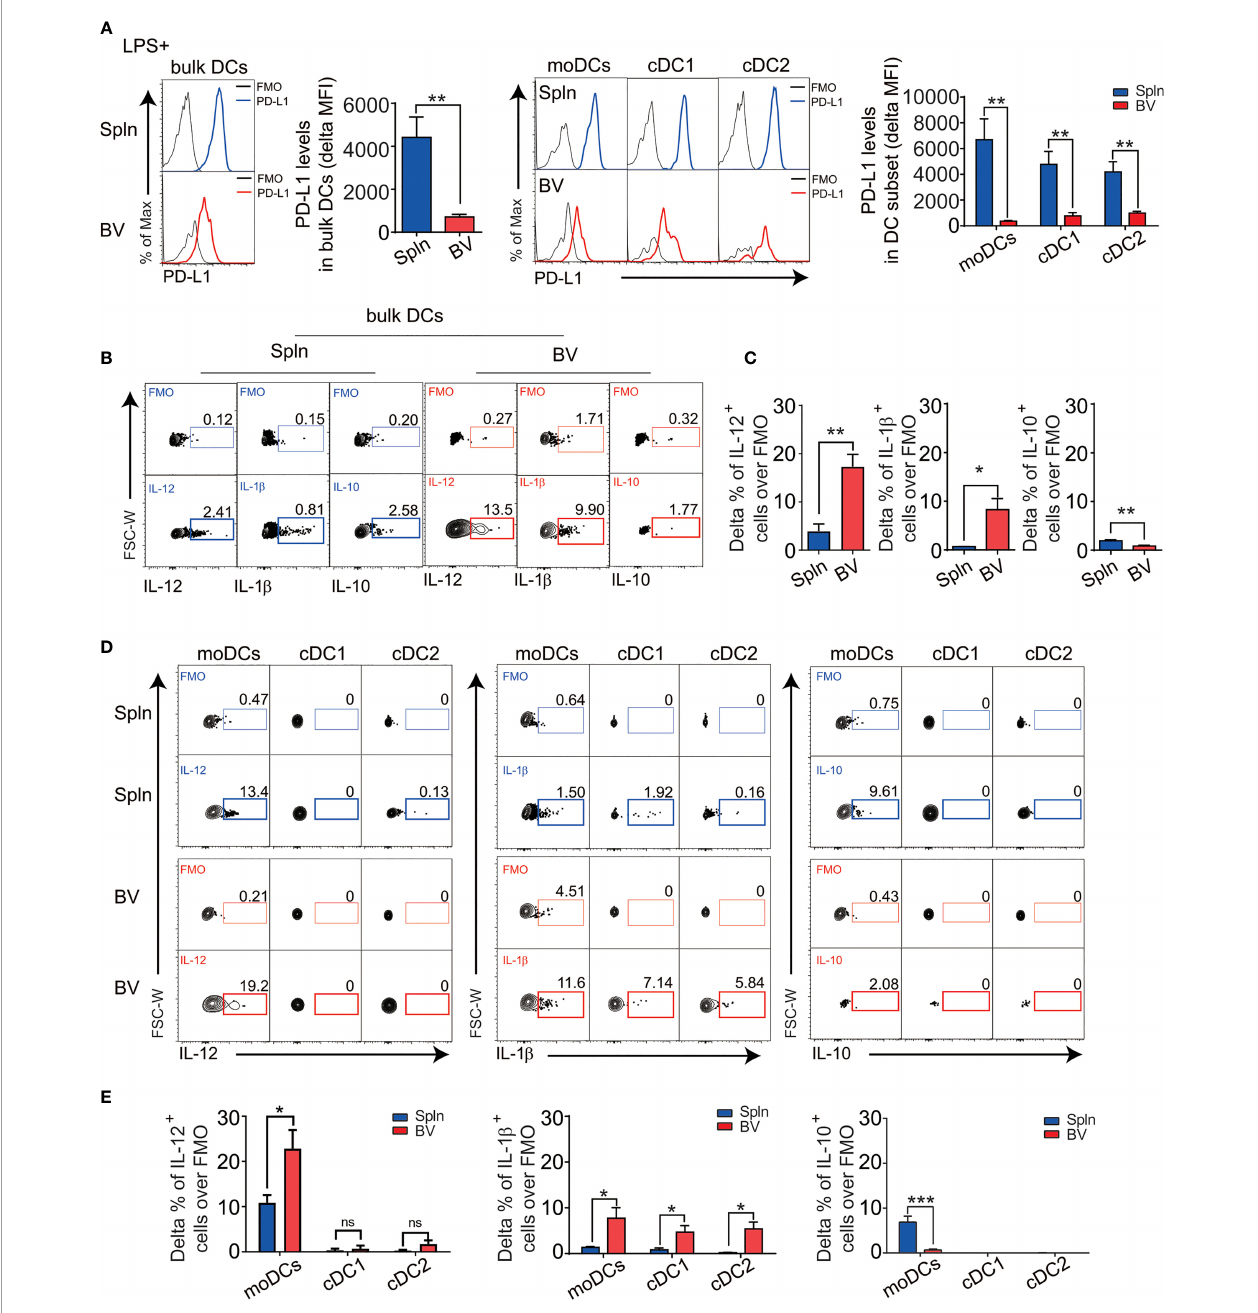
FIGURE 4 | The responses of DC in vascular tissues and spleen during in fl ammation. Mice were injected i.v. with 5 µg LPS for 12 h before their BV and Spln were taken. FACS plots and bar graphs show the delta MFI of PD-L1 in bulk DCs and their subsets (A) and the indicated cytokine contents in bulk DCs (B, C) and their subsets (D, E) . Shown here are representative plots of experiments with at least four biological replicates. The data are shown as mean ± SEM ( n = 4 – 8 mice) and analyzed using Student ’ s t -test. * p < 0.05; ** p < 0.01; *** p < 0.001. ns, no signi fi cant